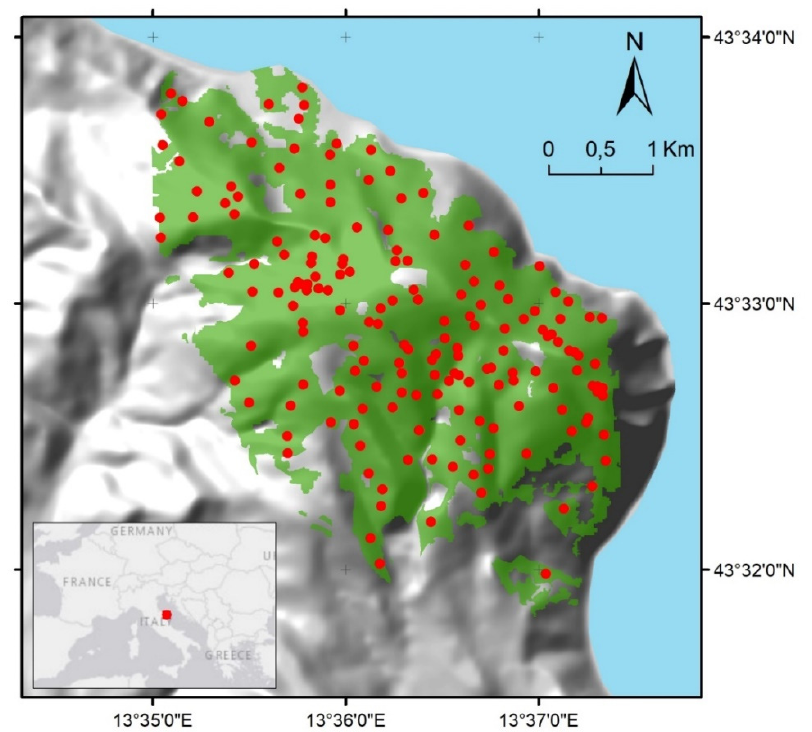
Figure 1. Study area. In green are the Mount Conero (Marche, Central Italy) forests investigated. The distribution is derived from the “Web Geographic Information System of Marche region” [7]. Red points are the reference data (field survey and photo-interpretation).